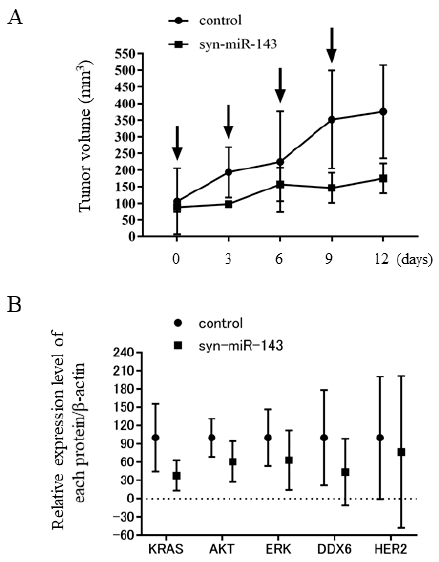
Figure 7. Anti-tumor effect of syn-miR-143 in vivo. ( A ) Time course of tumor size in KATO-III cell-xenografted nude mice treated with control RNA or syn-miR-143. Arrow represents an intravenous injection of control RNA (1.5 mg/kg/administration) or syn-miR-143 (1.5 mg/kg/administration) given every 3 days. ( B ) Western blot analysis of HER2, KRAS, AKT, and ERK1/2 in the samples from tumor tissues. Relative expression levels of each protein/ β -actin were calculated based on densitometric values of each protein and β -actin.